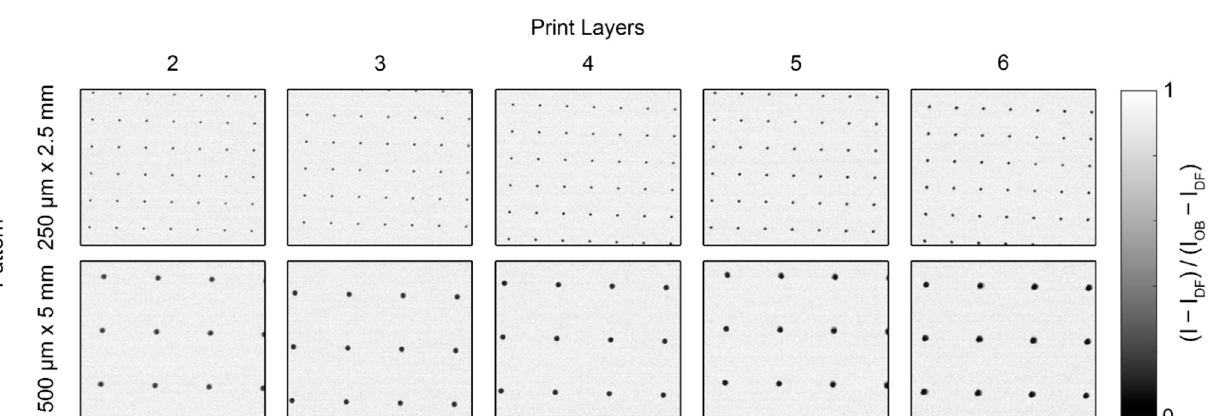
Figure 8. Composite normalized images of the prototype BB grids measured at CG-1D. 2.4.2. PMMA Step Wedge The grid centers for the open beam images were identified using the segmentation procedure described in the previous section. For the BT2 images of the step wedge, the BB